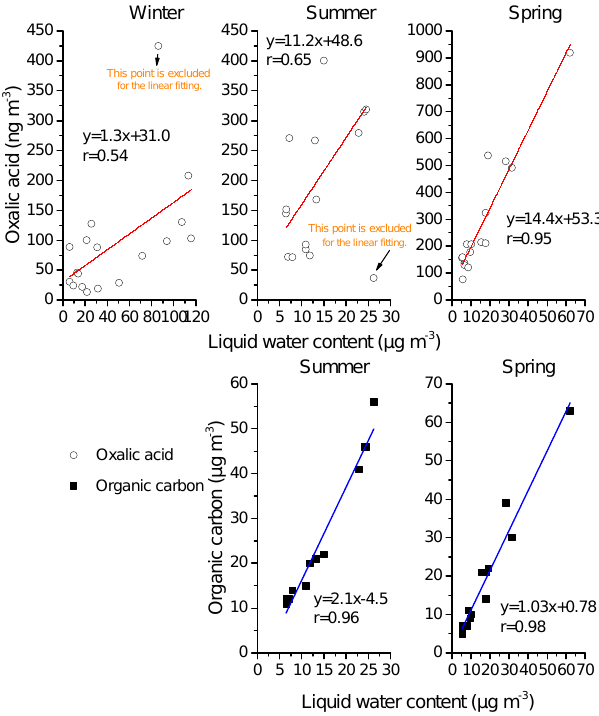
Figure 3. The linear fitting of the predicted liquid water content with organic carbon (OC) and oxalic acid aerosols during winter, summer and spring aircraft measurements over China.